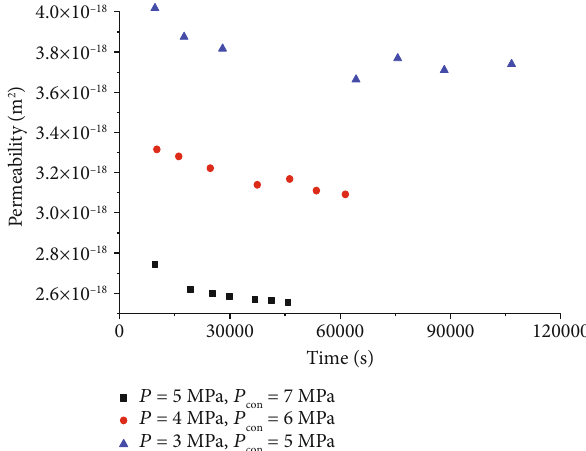
Figure 8: Permeability revolutions with time under constant di ff erence pressure